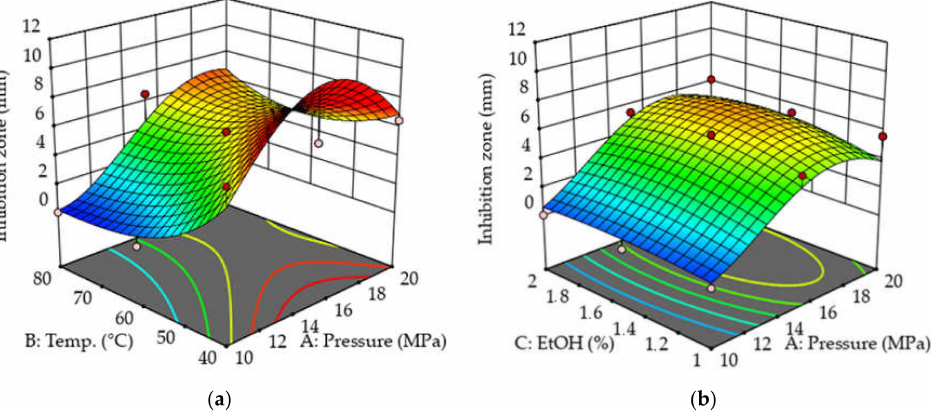
Figure 4. ( a ) Three-dimensional surface plot for variation of antibacterial activity on P. aeruginosa with changing extraction temperature and pressure. ( b ) Three-dimensional surface plot for variation of antibacterial activity on P. aeruginosa with modification of extraction pressure and ethanol ratio. The color scale shows the zones of inhibition from blue (0.00 mm) to red (7.51 mm).